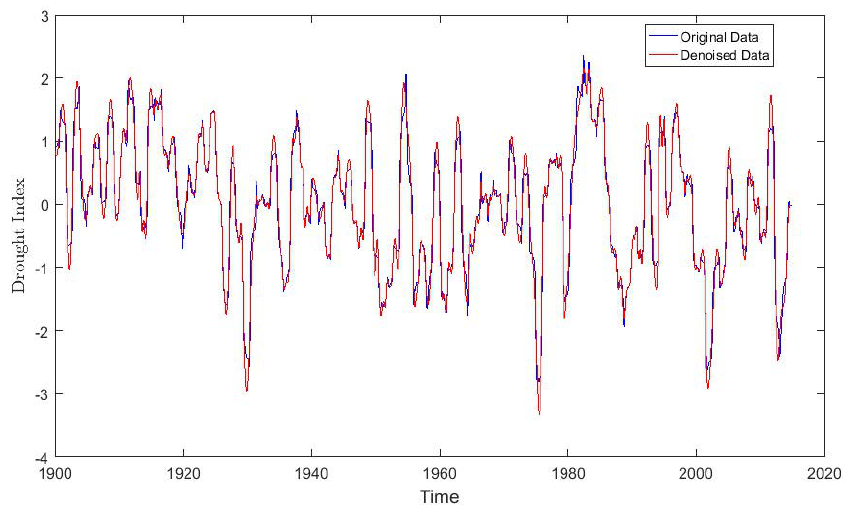
Figure 7. A plot of the original and reconstructed